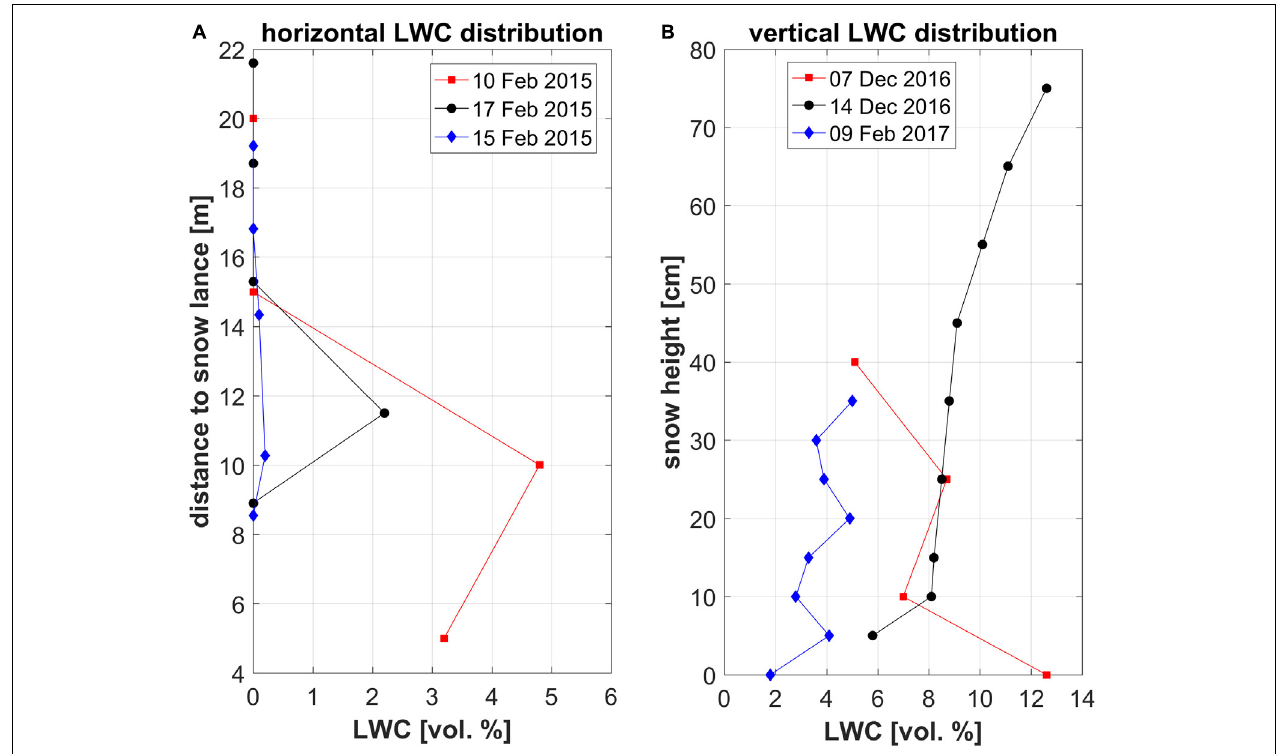
FIGURE 5 | Examples for horizontal (A) and vertical (B) distributions of liquid water content (LWC) for six snow-making